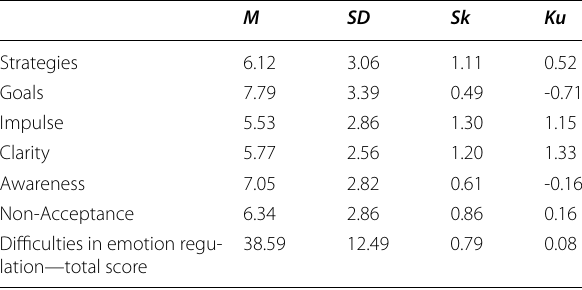
Table 5 Descriptive analysis for total sample ( N